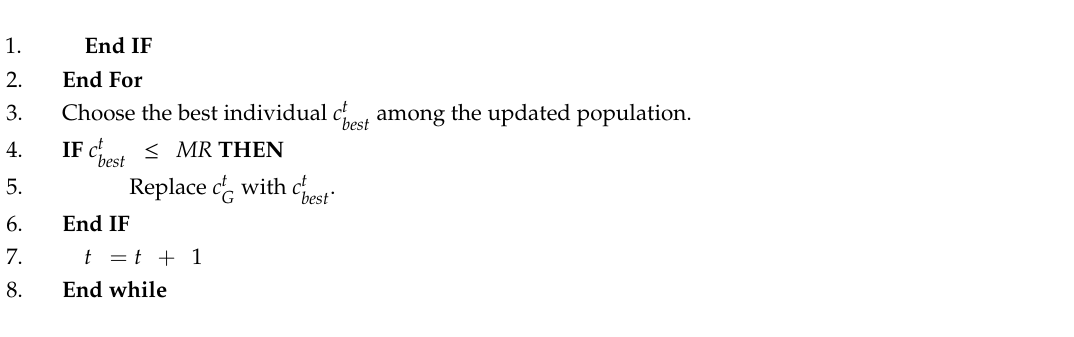
Algorithm 2: The proposed hybrid G-WOA Algorithm for ontology learning from Arabic